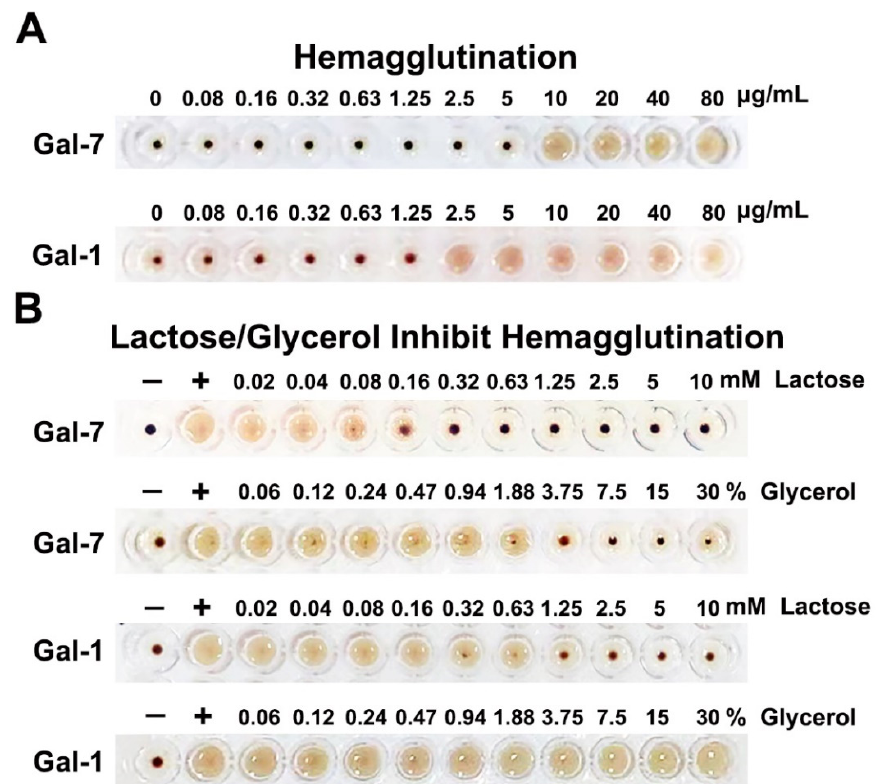
Figure 2. Hemagglutination assay. ( A ). Gal ‐ 7 ‐ induced agglutination of chicken erythrocytes with a MAC value of 10.0 µ g/mL. However, the MAC value for Gal-1 was only 2.5 µ g/mL. ( B ). Lactose MAC value of 10.0 μ g/mL. However, the MAC value for Gal ‐ 1 was only 2.5 μ g/mL. ( B ). Lactose could inhibit agglutination of chicken erythrocytes induced by Gal ‐ 7 and Gal ‐ 1. Glycerol could in ‐ could inhibit agglutination of chicken erythrocytes induced by Gal-7 and Gal-1. Glycerol could inhibit hibit Gal ‐ 7 ‐ induced agglutination of chicken erythrocytes but could not inhibit Gal ‐ 1. The concen ‐ Gal-7-induced agglutination of chicken erythrocytes but could not inhibit Gal-1. The concentration tration of Gal ‐ 7 and Gal ‐ 1 used in the inhibition assays were 10.0 μ g/mL and 2.5 μ g/mL, respectively. of Gal-7 and Gal-1 used in the inhibition assays were 10.0 µ g/mL and 2.5 µ g/mL, respectively. ‘+’ ‘+’ represents the positive control containing Gal ‐ 7 or Gal ‐ 1 but no lactose or glycerol. ‘ − ’ represents represents the positive control containing Gal-7 or Gal-1 but no lactose or glycerol. ‘ − ’ represents the the negative control of no Gal ‐ 7 or Gal ‐ 1. negative control of no Gal-7 or